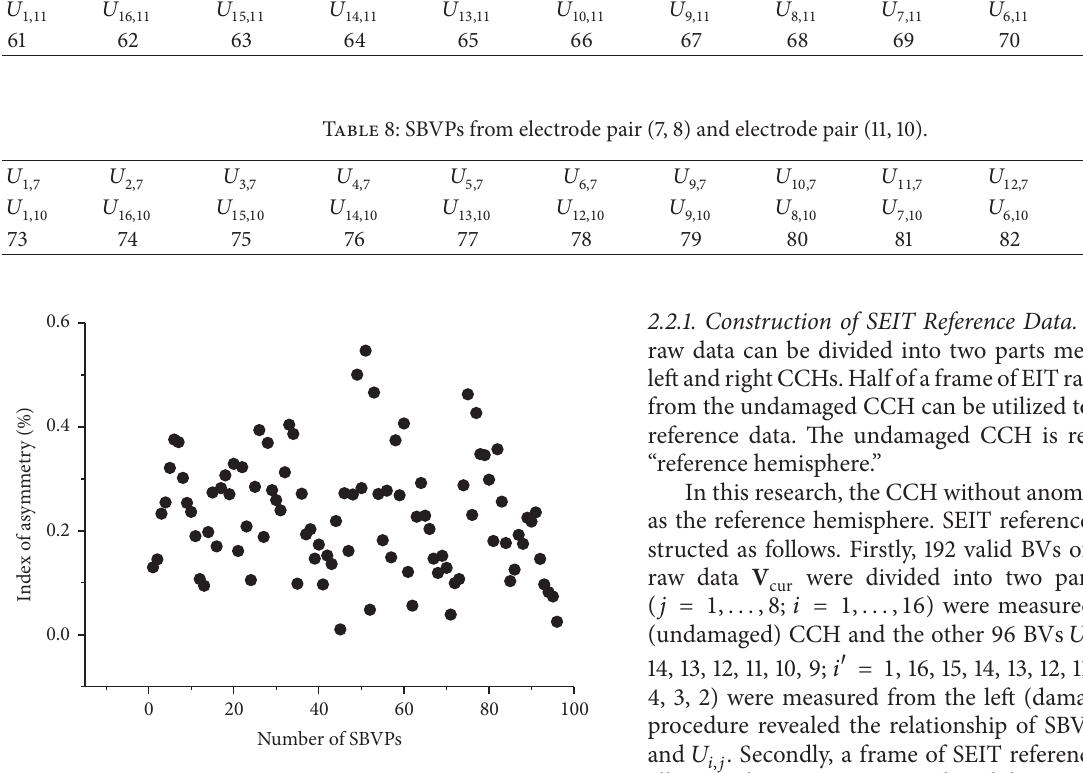
reflected the impedance asymmetrical degree of symmetrical regions in the two CCHs. The difference was defined as the index of asymmetry (IA) and was calculated by |𝐿 − 𝑅| IA = 100 × % (𝐿 + 𝑅) /2